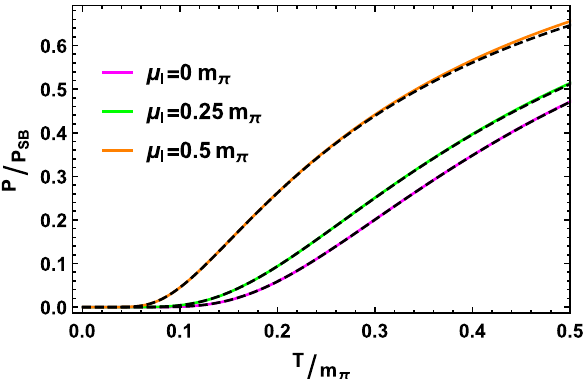
Fig. 6 Pressure normalized to the Stefan–Boltzmann pressure as a function of T / m π for three different values of μ I . See main text for